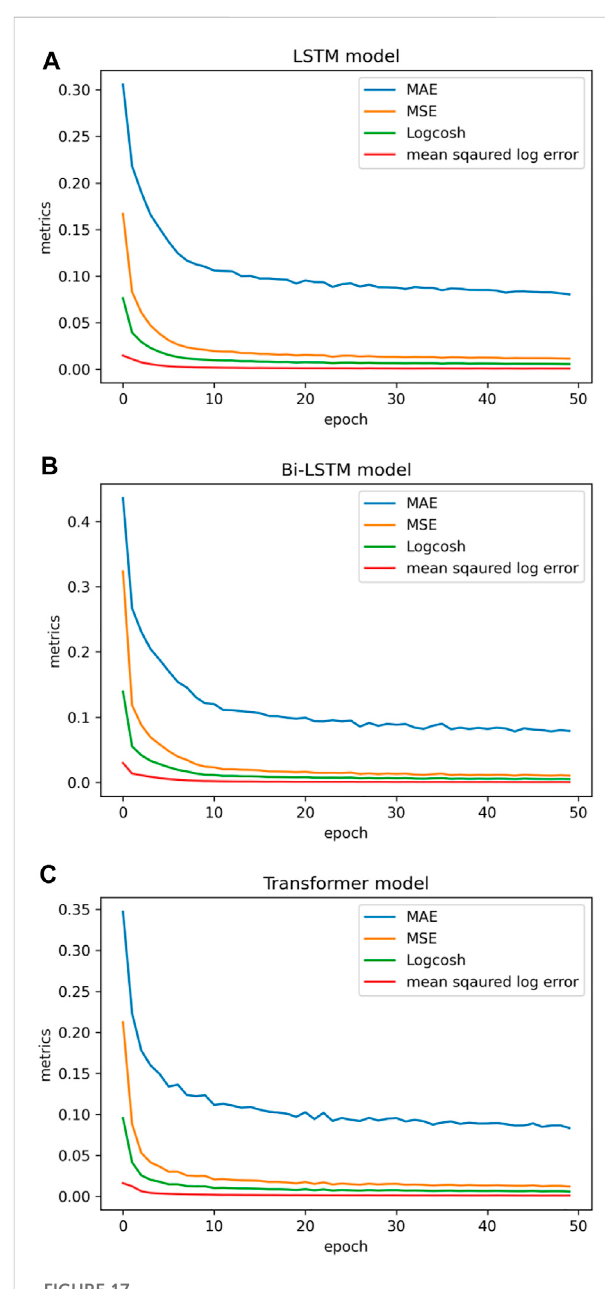
FIGURE 17 Performance metrics using (A) LSTM, (B) Bi-LSTM, and (C) transformer model on the Japan earthquake